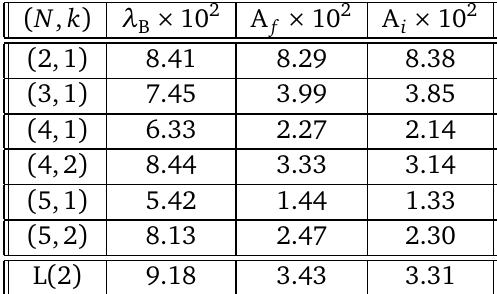
(profile width) and B ) were obtained by fitting the ,A f B were read off from the horizontal axis inter- i